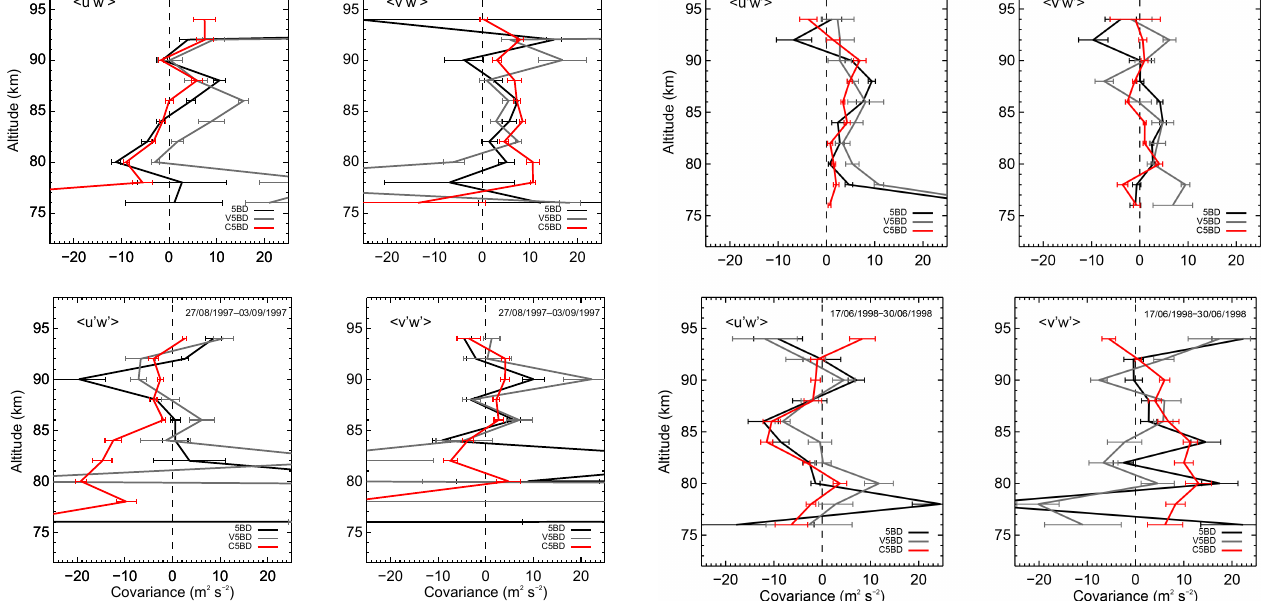
Figure 11. As per Fig. 10, for the October 1997 (upper panels) and June 1998 (lower panels)